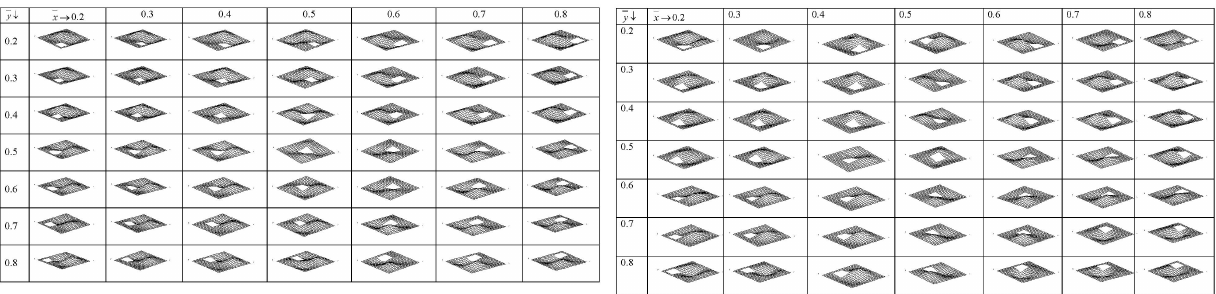
Figure 10: First mode shapes of laminated composite ( + 45/- 45/ + 45/-45) stiffened elliptic parabolic shell for different position of the central square cutout and CCCC boundary condition.